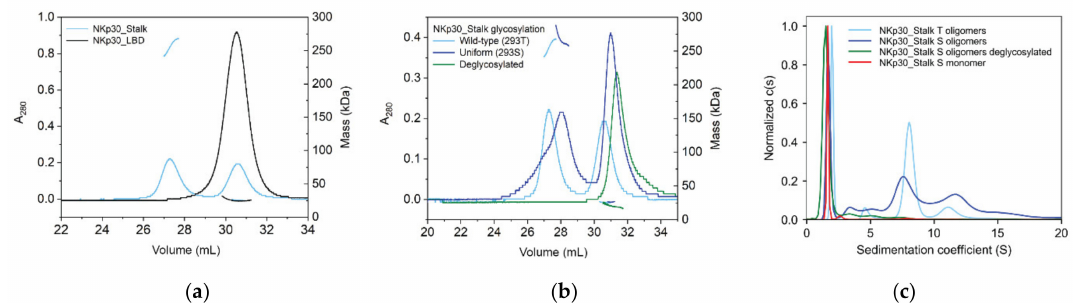
Figure 5. Glycosylation is necessary for NKp30 oligomerization. ( a ) SEC-MALS analysis of NKp30_Stalk and NKp30_LBD, confirming that the stalk region is required for oligomerization. ( b ) SEC-MALS analysis of recombinantly expressed NKp30_Stalk with wild-type glycosylation (black), uniform, simple glycans (blue), both showing non-covalent oligomers, and deglycosylated sample, which does not form oligomers (red). ( c ) Normalized continuous size distributions of sedimenting species for glycosylated and deglycosylated NKp30_Stalk oligomers and for its monomeric fraction. The main peak corresponds to the NKp30_Stalk monomer, whereas a broad distribution of oligomeric species is present in glycosylated NKp30_Stalk